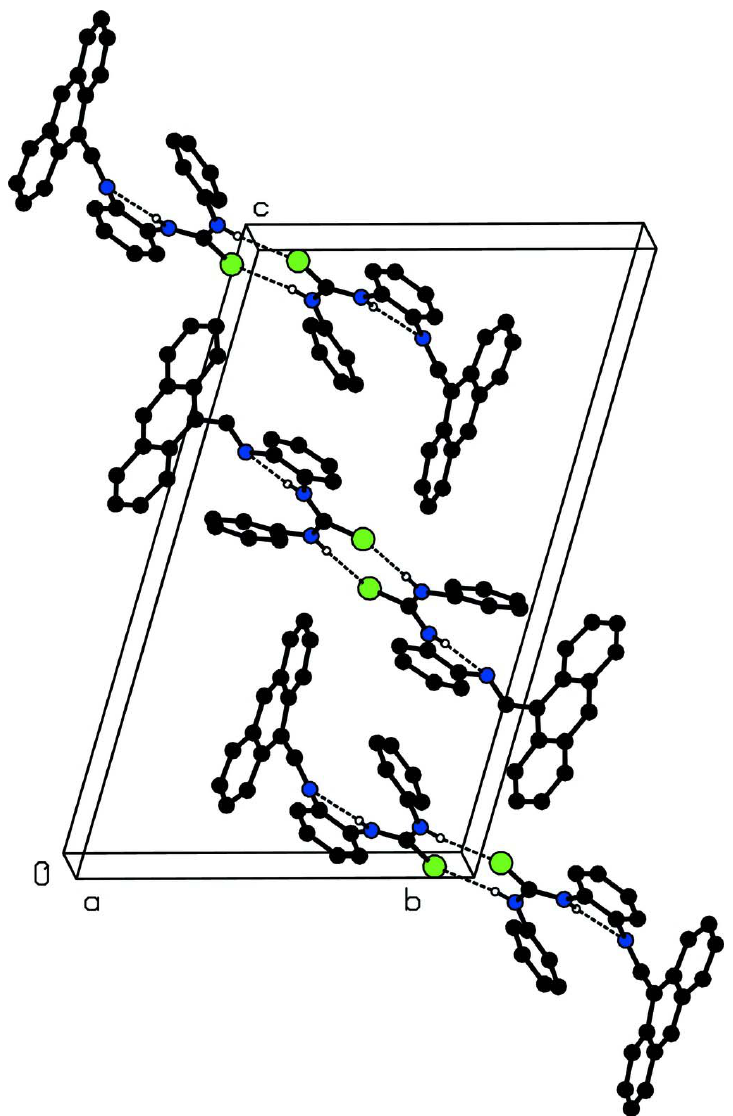
The molecular packing of (I), viewed down the a